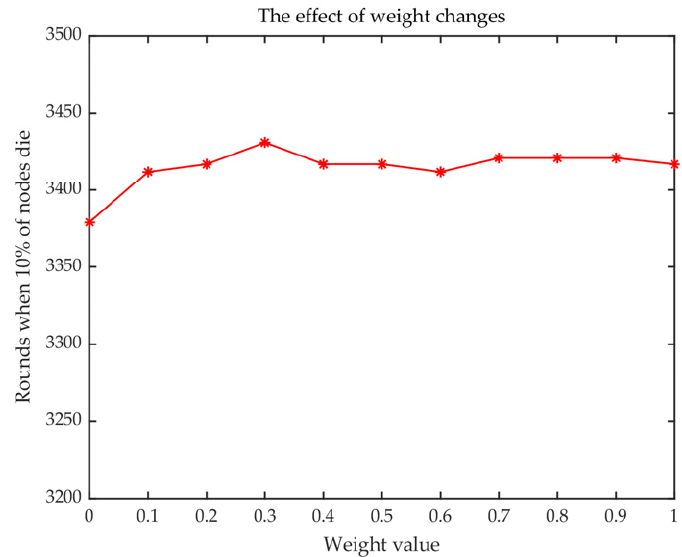
Figure 6. Selection weight of Formula (17).